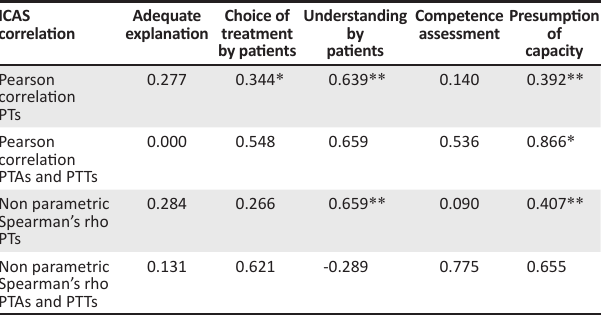
TABLE 2: Correlation between informed consent aggregate score and summated attitude score. ICAS Adequate Choice of correlation explanation